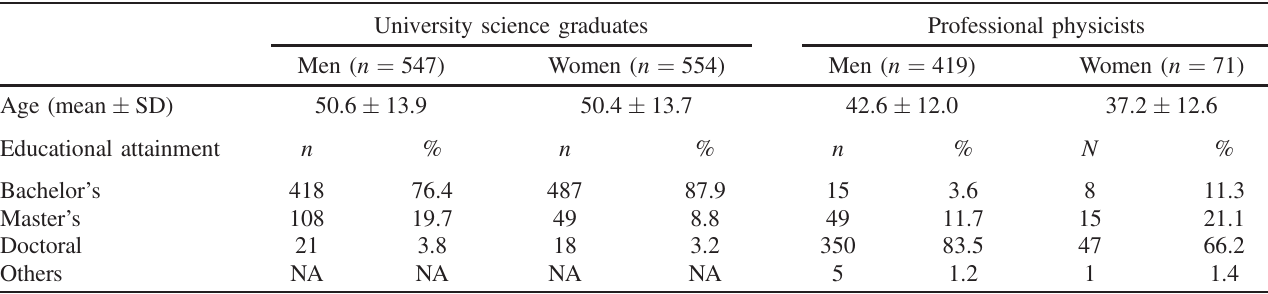
TABLE II. Demographic information showing age, gender, and educational attainment of